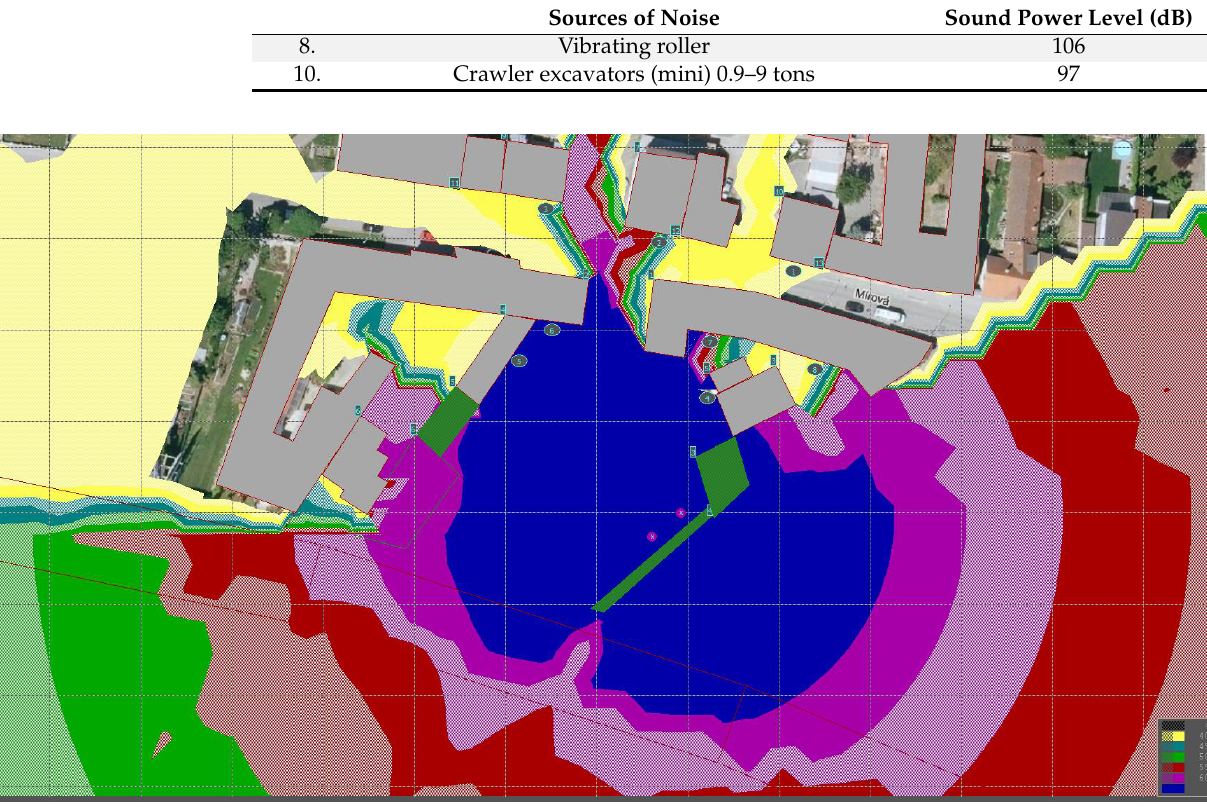
Figure 19. Colour map of isophone bands after considering acoustically significant elements (without construction site fencing or a solid gate) for the final landscaping in the investigated area, with the deployment of both machines. Table 24. Table of points from the calculation of measured points for final landscaping without construction site fencing or a solid gate for the investigated area, with the deployment of both machines. LA eq (dB)